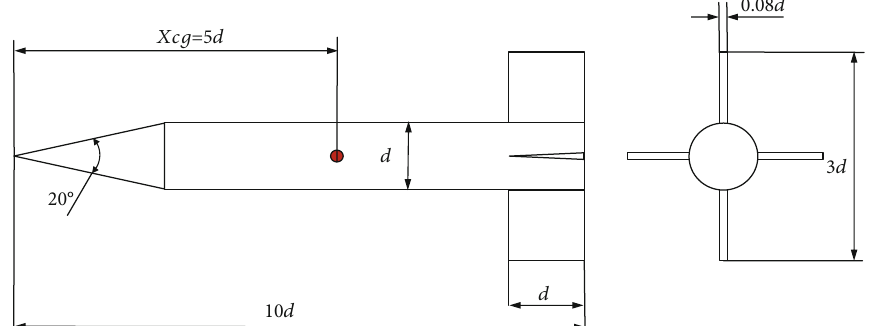
Figure 3: Finner missile con fi guration.